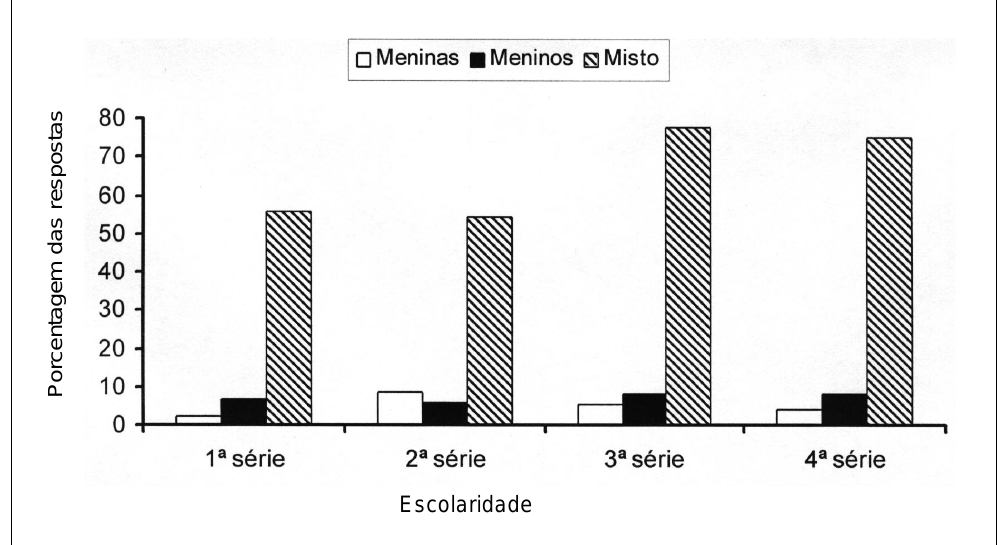
Escolaridade Figura 1. Porcentagem das classificações pelas meninas, por séries, das brincadeiras exclusivas de meninos, de meninas ou mistas